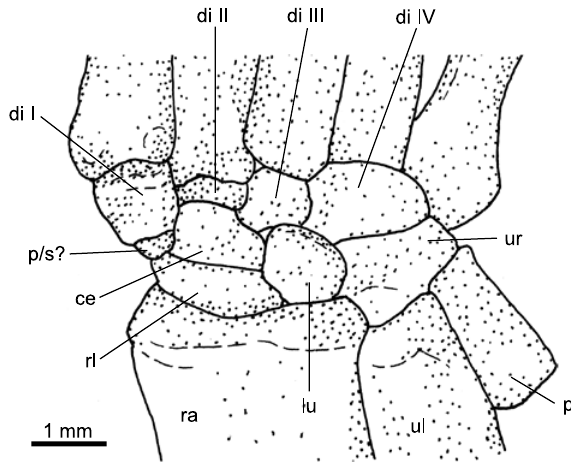
Fig. 12. Carpus of Zhangheotherium quinquecuspidens Hu, Wang, Luo, and Li, 1997, IVPP V7466, Jianshangou Valley, Liaoning Province, China, Barremian, right carpus, dorsal view. Abbreviations: di, distal carpal; ce, centrale; lu, lunate; p/s, prepollex/sesamoid, probably a fragment; pis, pisi- form; ra, radius; rl, radiale; ul, ulna; ur,